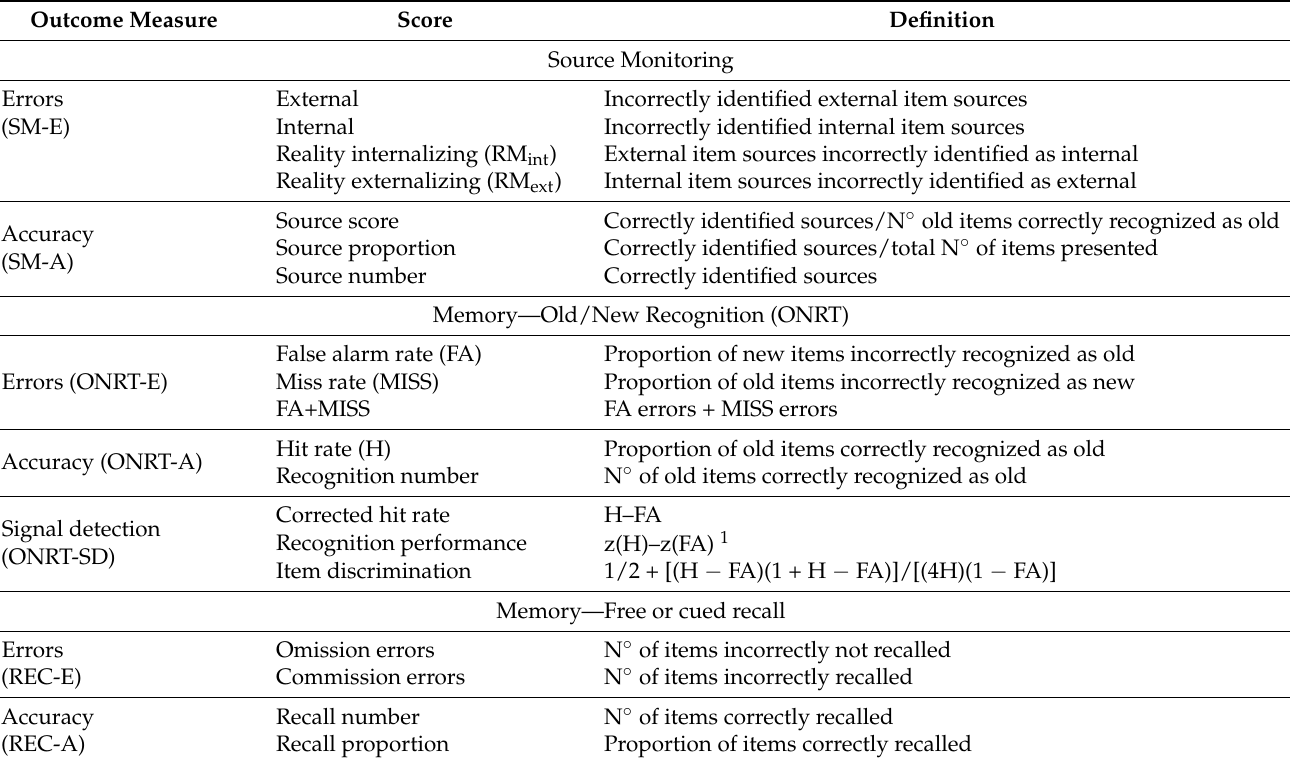
Table A2. Definitions of source monitoring and memory